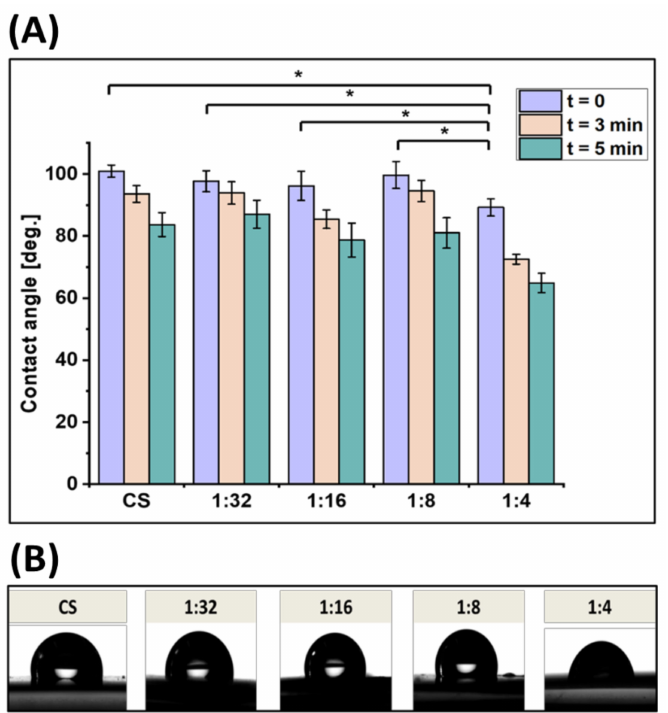
Figure 3. ( A ) Average contact angle of water droplets on CS and Ga (III)-CS complex coatings